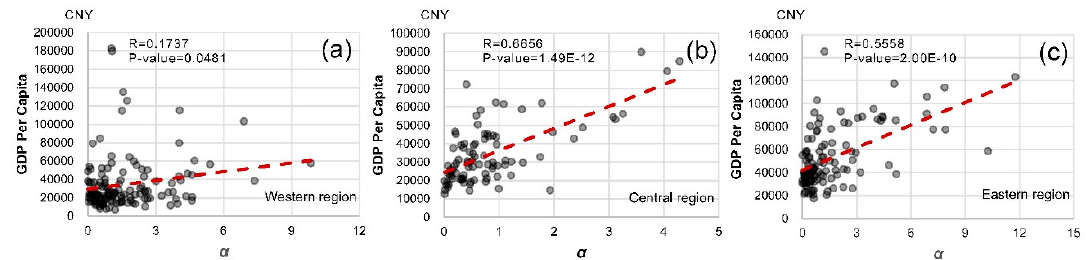
Figure 6. Correlations between α and GDP per capita of all cities in ( a ) western region, ( b ) central region, and ( c ) eastern region.